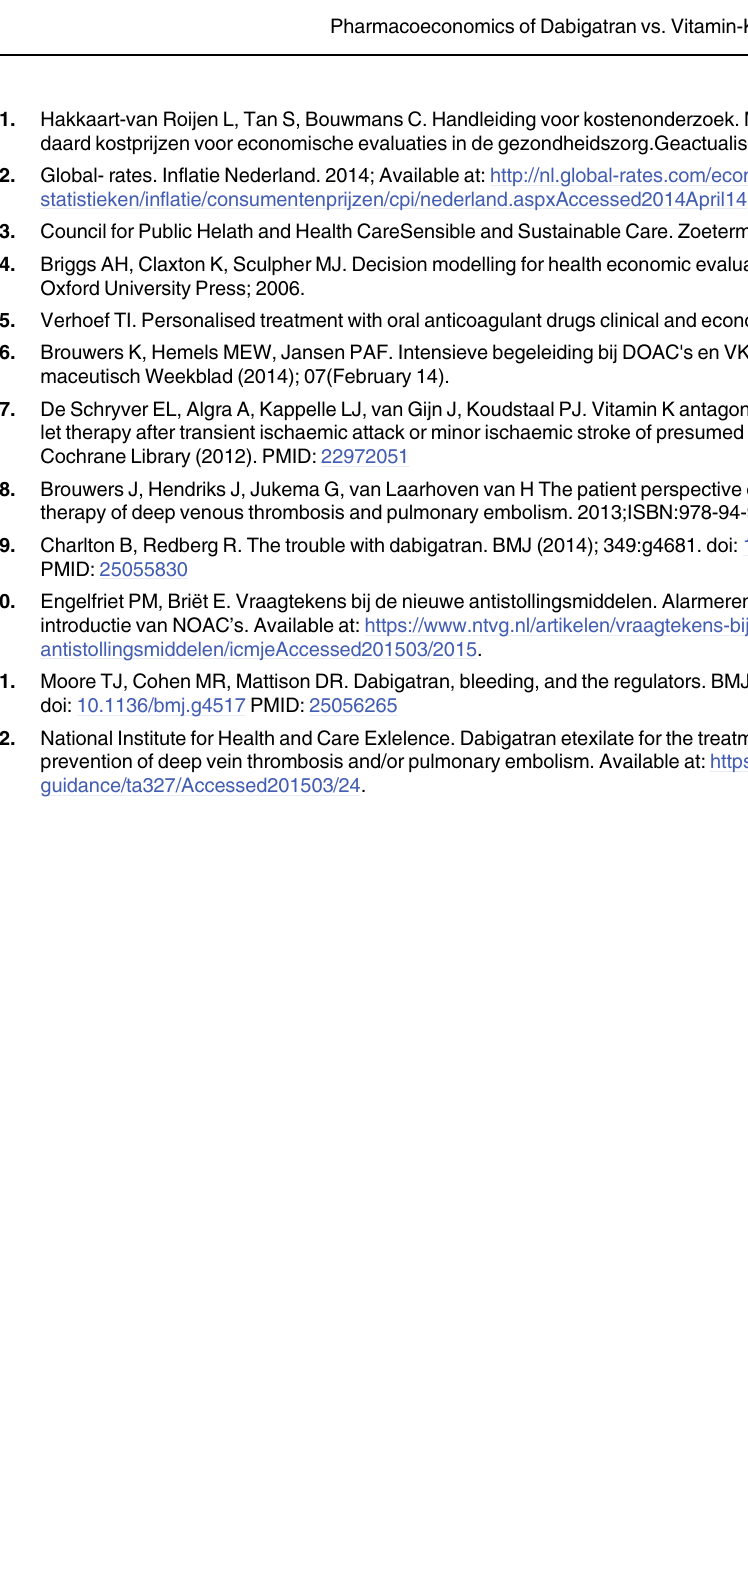
PLOS ONE | DOI:10.1371/journal.pone.0135054 August 4,